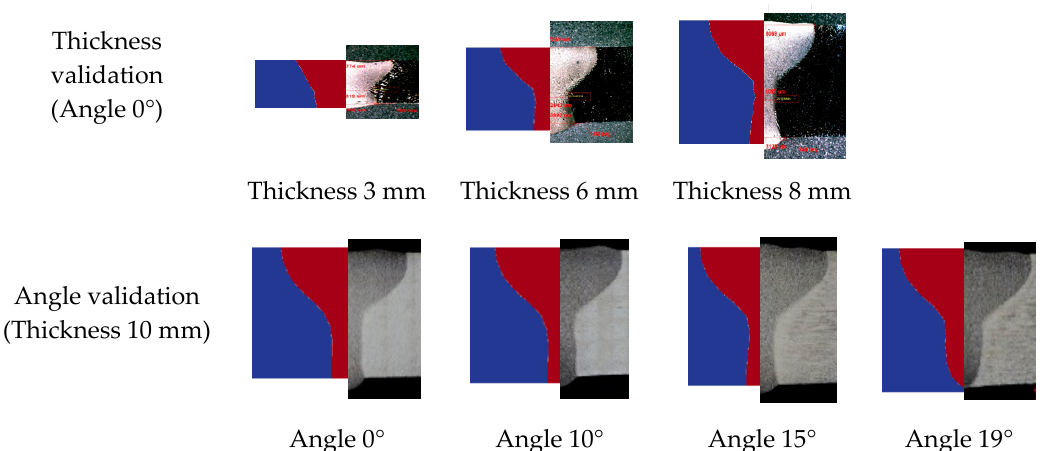
Figure 9. Validation of the simulation with the physical welds for the different beam incident angles and thicknesses. and